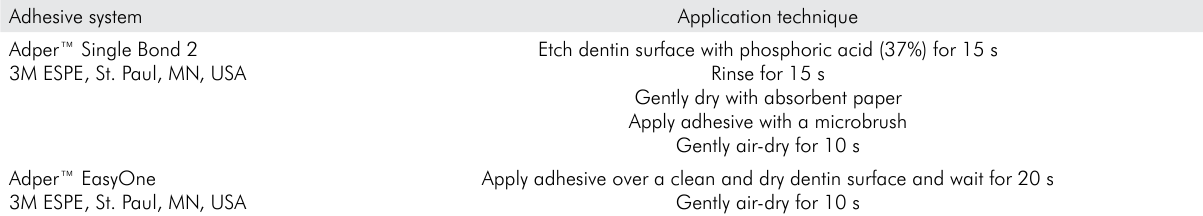
Table 1. Application technique for each dentin bonding system according to its manufacturer’s